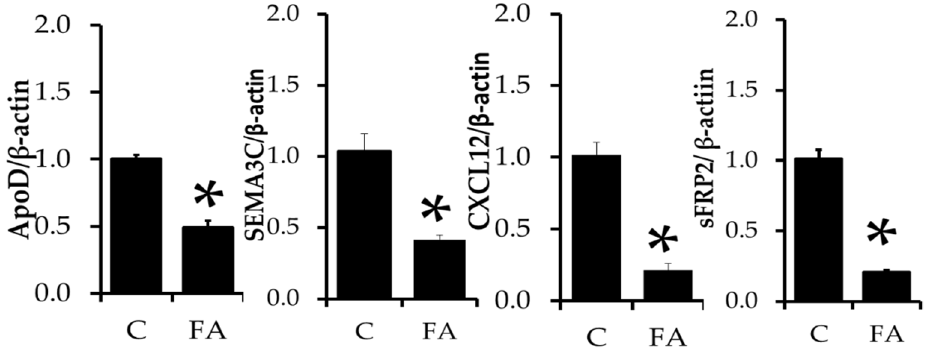
Figure 3. Transcriptional changes in apolipoprotein D (ApoD), semaphorin 3C (SEMA3C), C-X-C chemokine ligand 12 (CXCL12) and secreted frizzled related protein 2 (sFRP2) in FA-treated and control adipocytes. The results are represented as the mean ± standard error of the mean of three replicates. * p < 0.05 statistically significant difference between control and treated group.